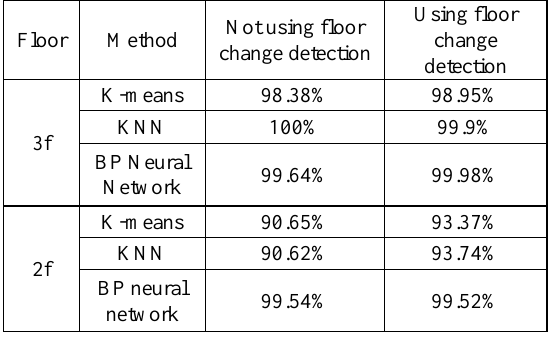
Table 2: Comparison of total accuracy of distinction In the scenario of floor changed, since the accuracy of our floor change detection method is 100% in elevator situation, and around 97% in staircase situation, when failing to detect floor change, the accuracy of floor identification will decrease. But for the area maybe changed is smaller than that won’t change, it will not affect too much for identification accuracy. In addition, the incorrectness of distinction has been decreased under the no floor change situation, so that the accuracy of the whole three methods has been promoted 1.645%, 1.56%,